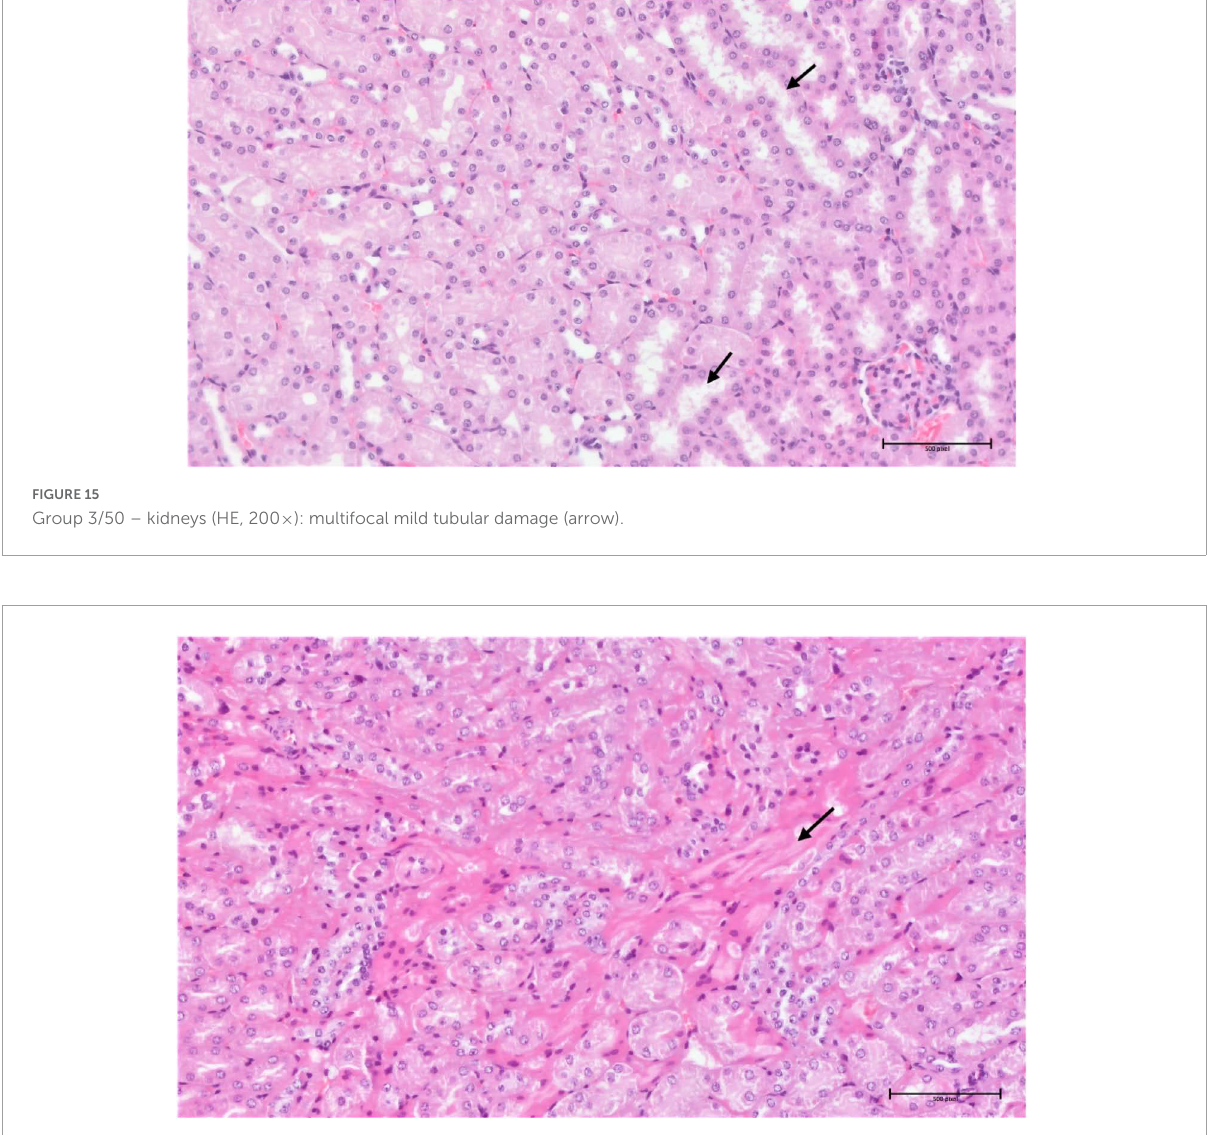
FIGURE16 Group torkinib/5 – kidneys (HE, 200 × ): focal interstitial fibrosis (arrow), mild tubular damage, hyaline